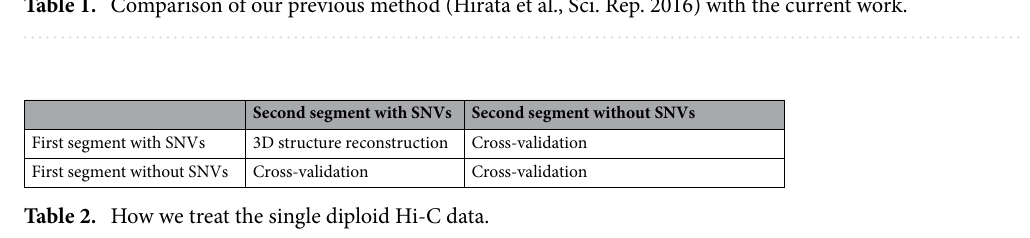
Table 1. Comparison of our previous method (Hirata et al., Sci. Rep. 2016) with the current work.